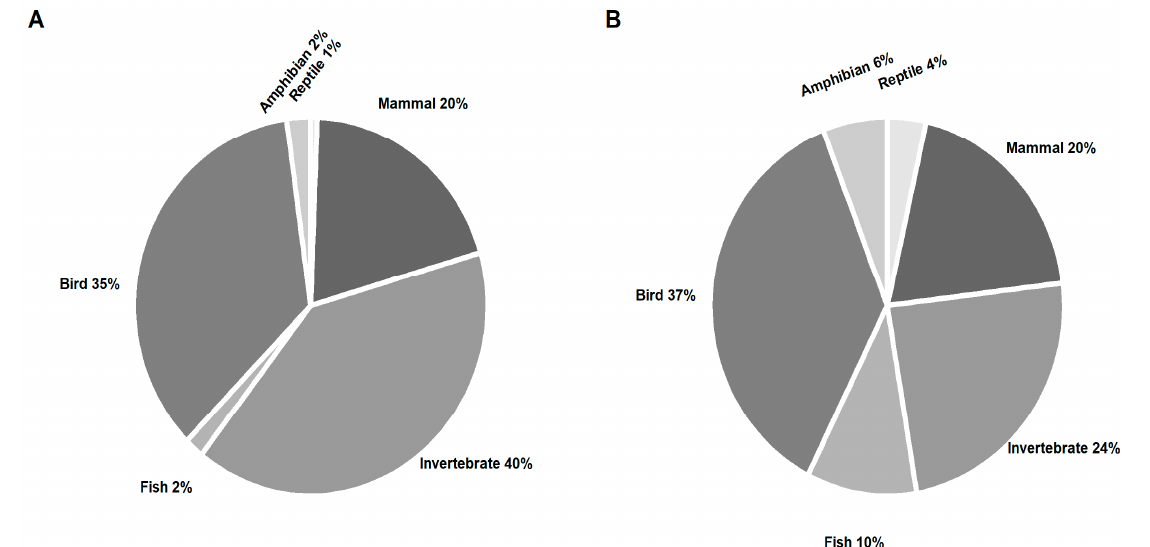
Figure 1. Proportions of observations made for different types of animals and behaviors recorded by social media and scientific literature. The proportion of animal groups observed recorded by social media during the 2017 Great American solar eclipse ( A ) and the scientific literature during multiple previous eclipses ( B ) is reported as a percent of the total number of observations made for each source (social media and scientific literature each total 100%). All observations were classified into one of six types of animals (amphibian, bird, fish, invertebrate, mammal, or reptile).